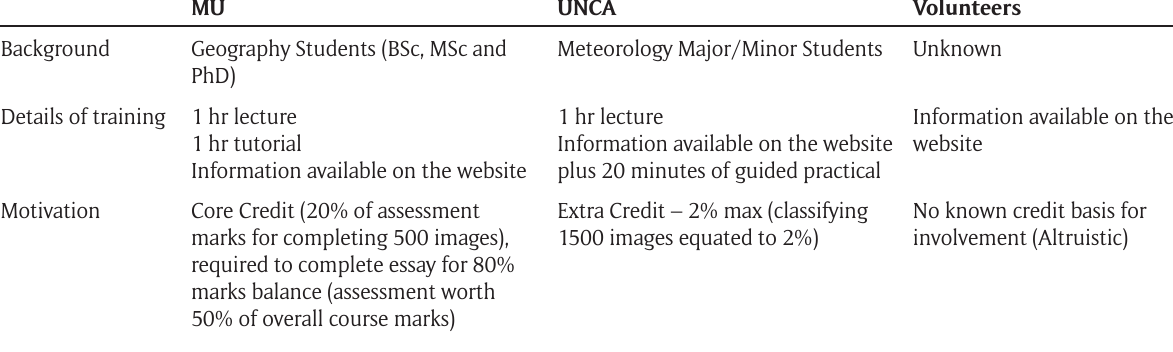
Table 1: Summary of the participant groups. MU is Maynooth University; UNCA is University of North Carolina